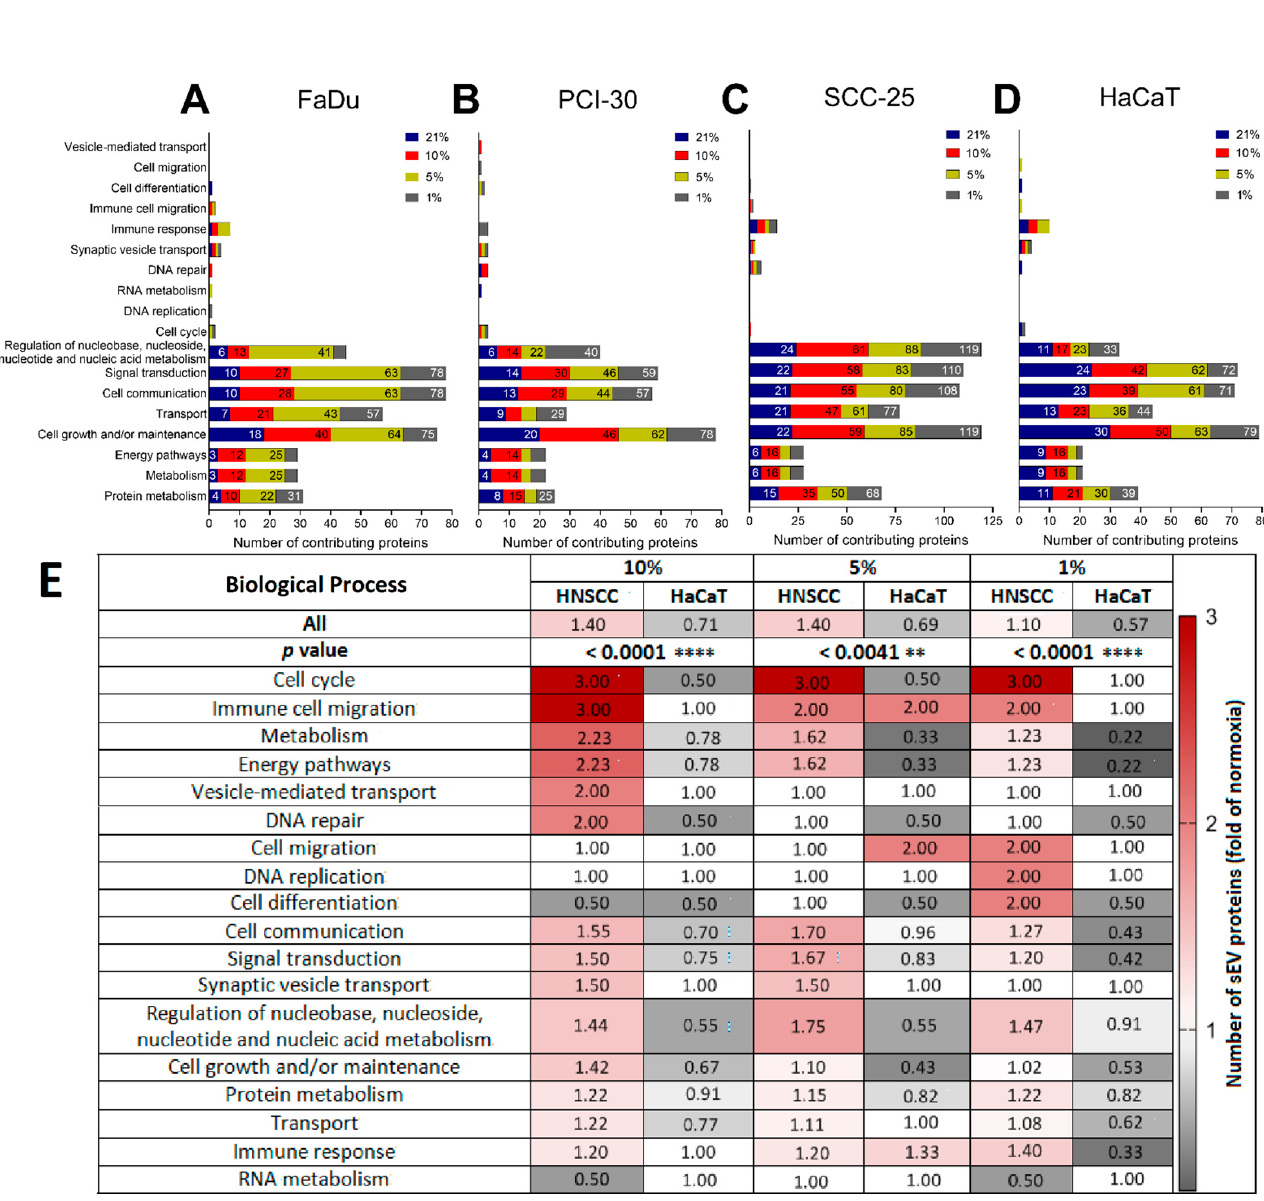
Figure 4. Proteome profile distribution of sEVs deriving from ( A ) FaDu, ( B ) PCI-30, ( C ) SCC-25, and ( D ) HaCaT cells cultured in various oxygen concentrations (21, 10, 5, and 1% O 2 ) according to their major functional FunRich annotations. ( E ) Dataset of cancerous and non-cancerous sEV proteins presented as fold change of normoxia with regards to changes in contributions to all and specific biological processes, **** p < 0.0001, ** p < 0.01.